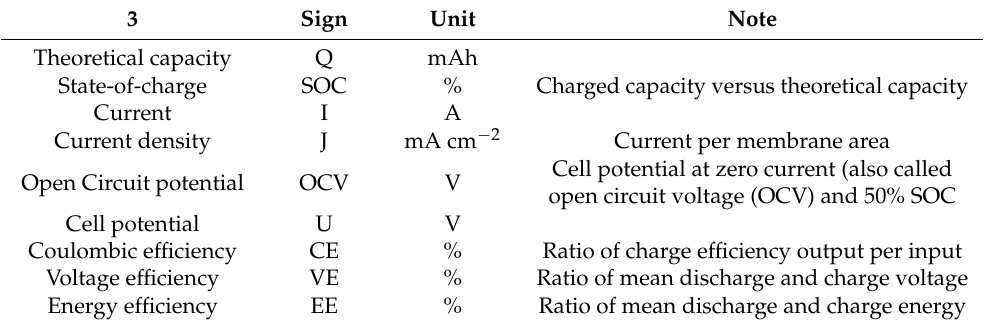
Table 1. Most important electrochemical cycling parameters and cell-performance variables